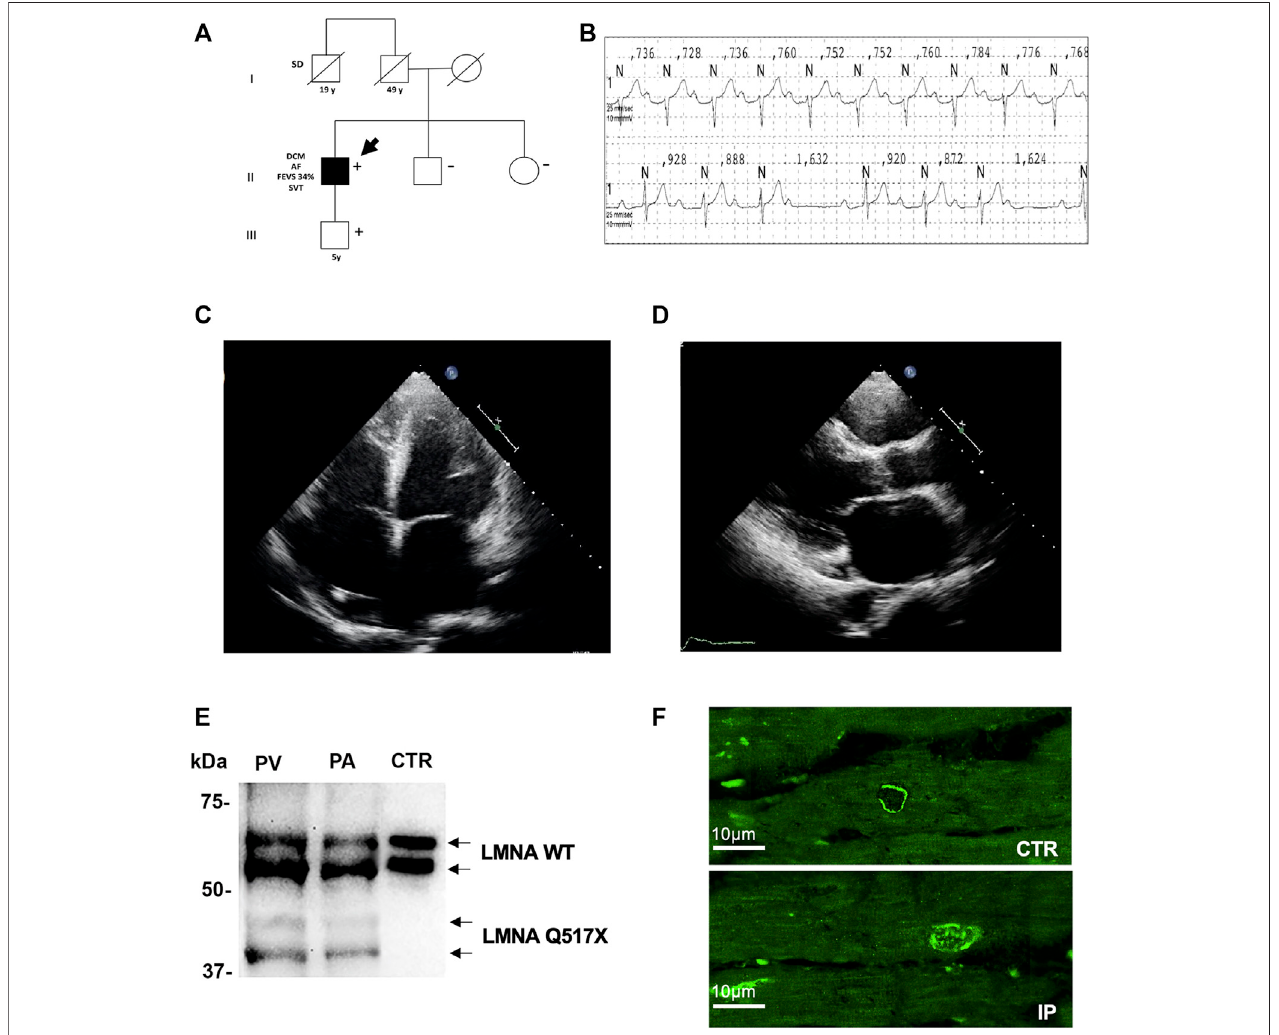
FIGURE 1 | (A) Pedigree of the family carrying the LMNA Q517X pathogenic variant. The fi lled symbols indicate clinically affected individuals, the diagonal slashes indicate deceased individuals; +/ − indicate positive/negative for the mutation; the arrow indicates the index patient. (B) ECG data from index patient showing sinus rhythm, fi rst-degreeatrioventricularblock(uppertrace),andtype1second-degreeatrioventricularblock(lowertrace)recordedduringa24-hECGmonitoring. (C) Apical 4Cviewsofechocardiographicimagingfromindexpatientshowingaspherical,severelydilated,andmarkedlyhypocontractileleftventricle. (D) InthePLAXviewof echocardiographic imaging from index patient, showing a highly dilated left atrium. (E) Western blot analysis of whole lysate of left atrium (PA) and (PV) ventricular myocardialtissuefrom the mutant carrier (black arrow in A) and control (CTR) heart biopsies. (F) Representative confocal immuno fl uorescence images ofLMNA in heart biopsies from a control patient (CTR) and from the index patient (IP). ECG, electrocardiogram; PLAX view, parasternal long-axis view.